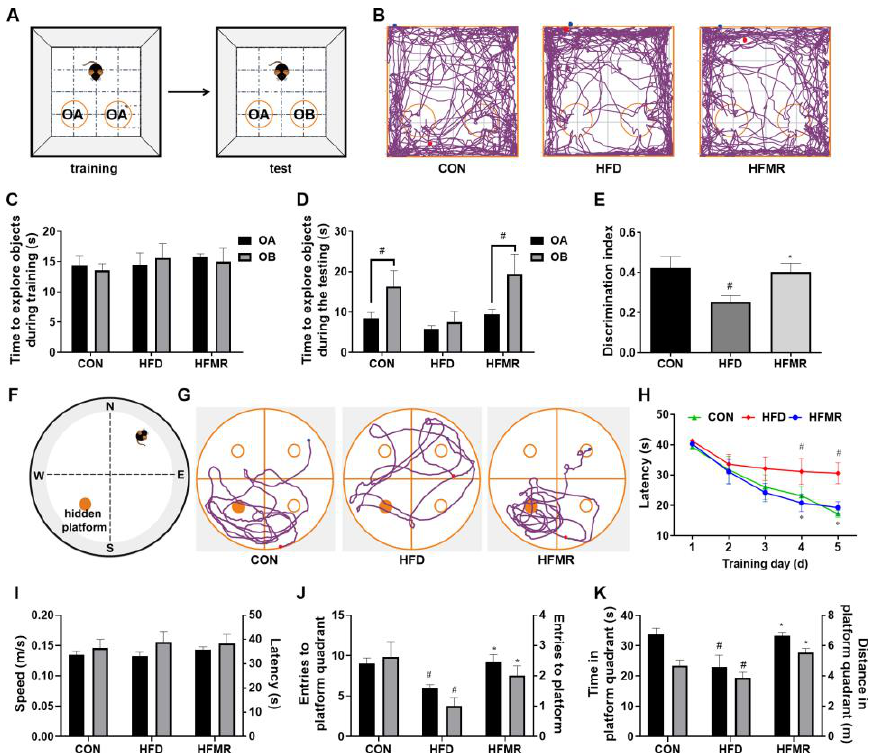
Figure 1. Effects of MR on cognitive ability in HFD-induced insulin-resistant mice. ( A ) Diagram of the NOR. ( B ) Tracking paths of mice in NOR. ( C ) Time to explore objects during training. ( D ) Time to explore objects during the test. ( E ) Discrimination index (DI). ( F ) Diagram of the MWM. ( G ) Tracking paths of mice in MWM. ( H ) Latency in the platform hiding period. ( I ) Speed and latency in the platform visibility period. ( J ) Number of entries into the platform quadrant and the platform in the platform hiding period. ( K ) Staying time and moving distance in the platform quadrant during the platform hiding period. All data are shown as the mean ± SEM ( n = 8). # p < 0.05 (HFD vs. CON); * p < 0.05 (HFMR vs.